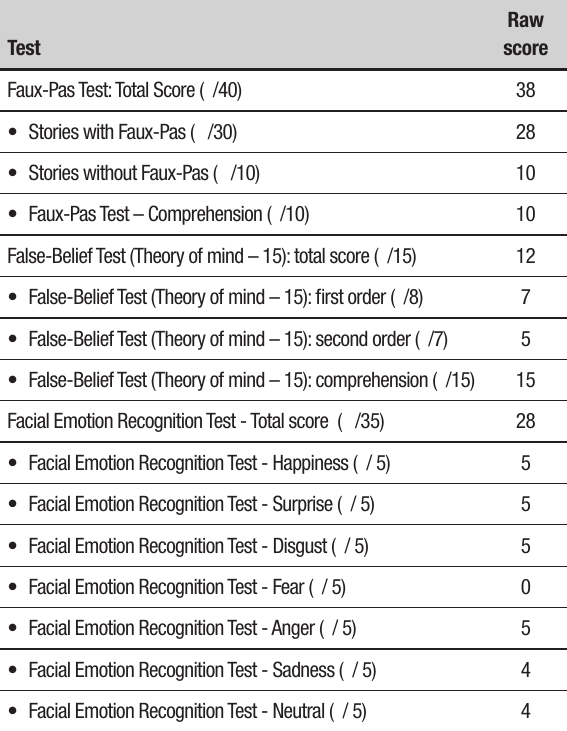
Table 2. Social Cognition Assessment (August 2018).